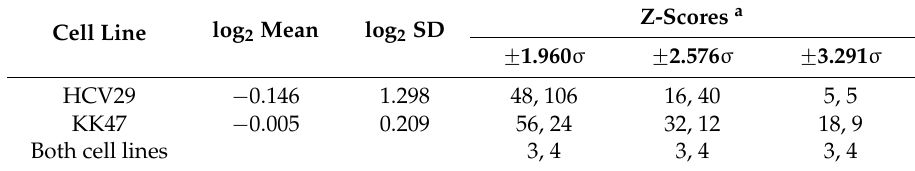
Table 1. Protein number, log 2 ratio, mean ˘ SD, and z-scores of SILAC-labeled